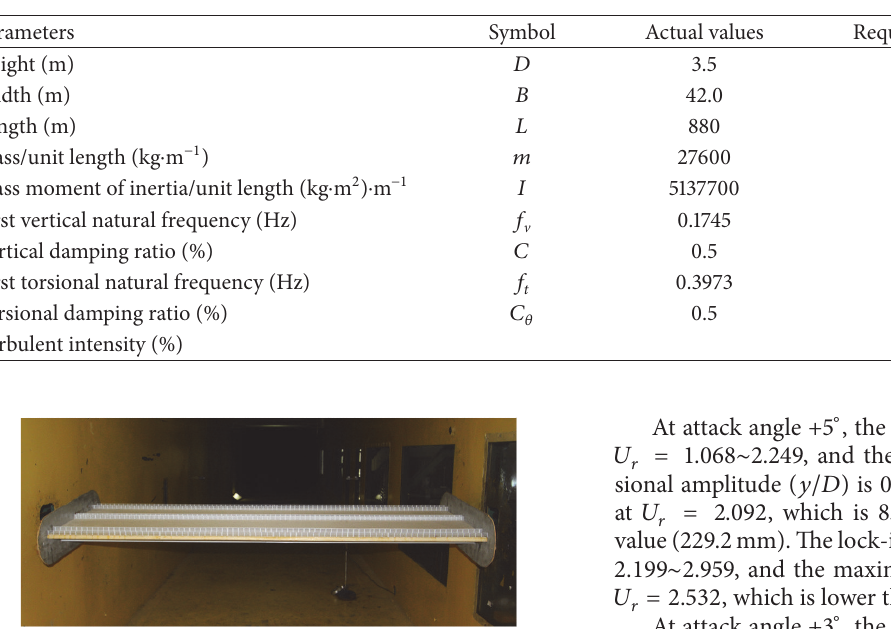
Table 1: Design parameters of wind tunnel tests.